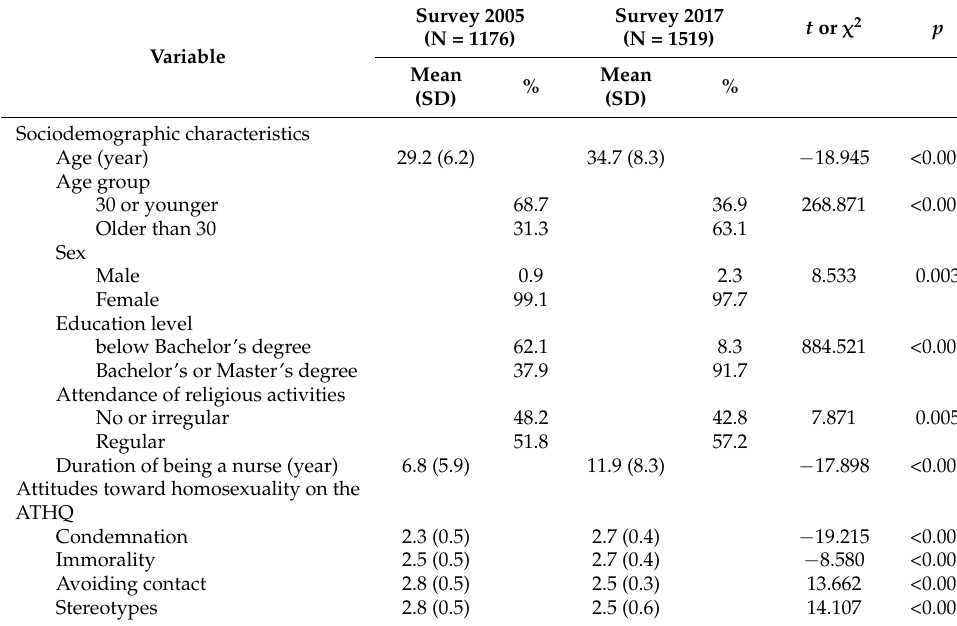
Table 1. Sociodemographic characteristics and attitudes toward homosexuality among nurses in Survey 2005 and Survey